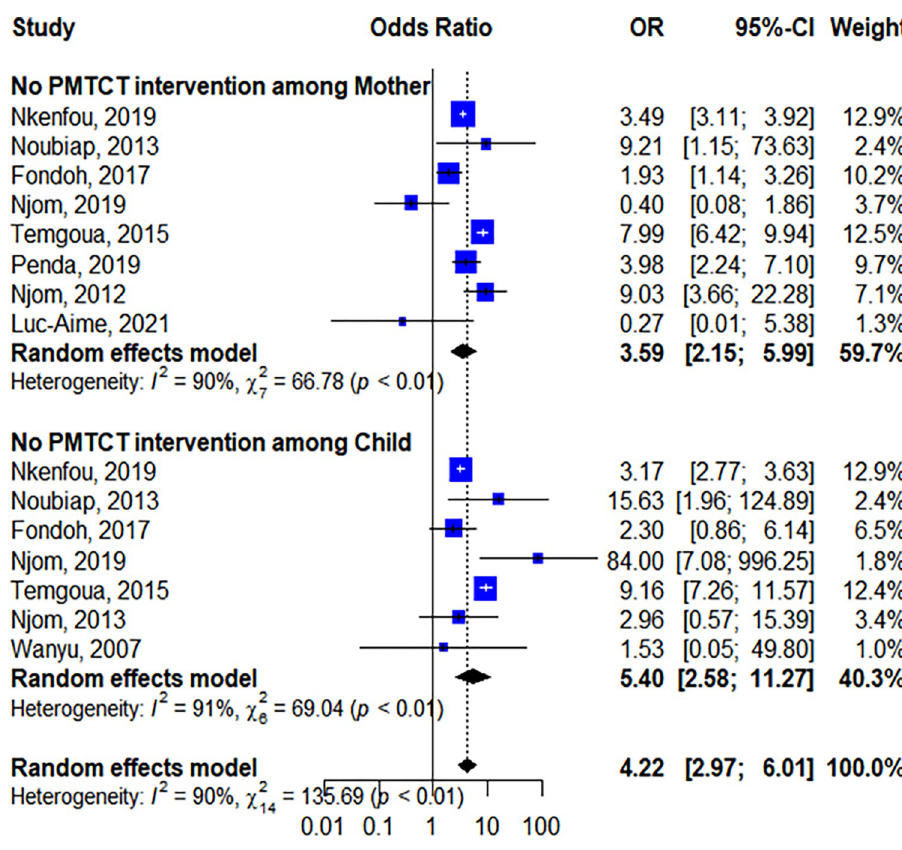
Fig 9. Association between MTCT of HIV and prevention of mother-to-child transmission intervention.